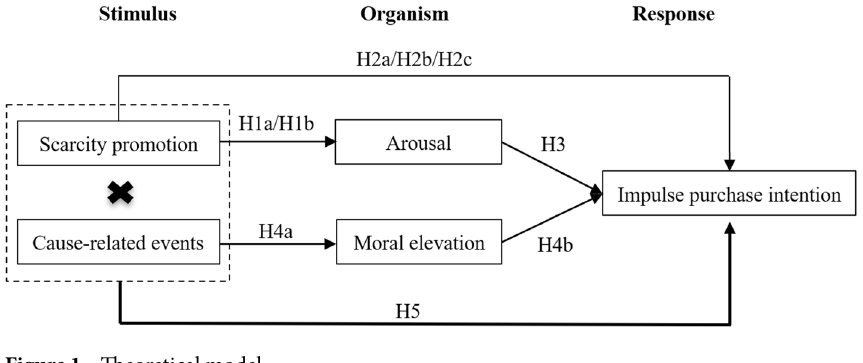
Figure 1. Theoretical model.